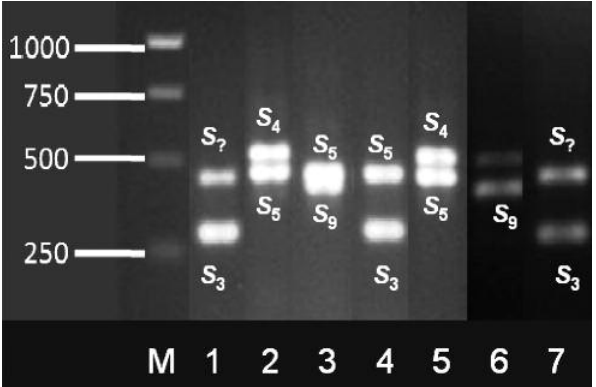
1 Sized on automated sequencer 2 Sized on agarose gels by comparing with 1 kb+ size marker 3 It must be confirmed by allele-specific